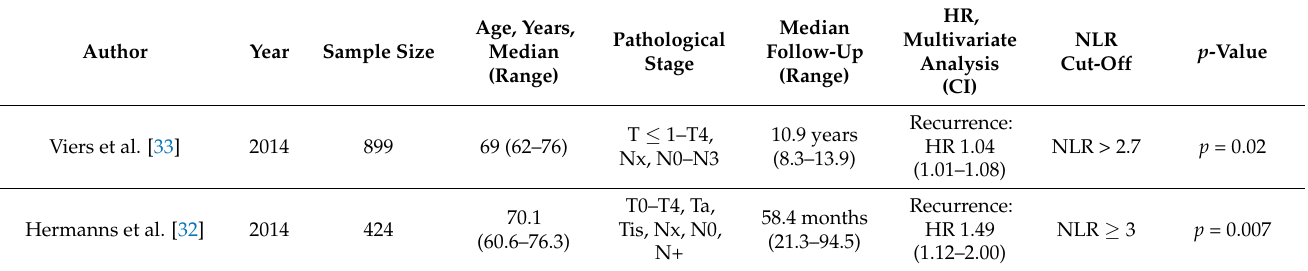
Table 2. Eligible studies for the meta-analysis and their study